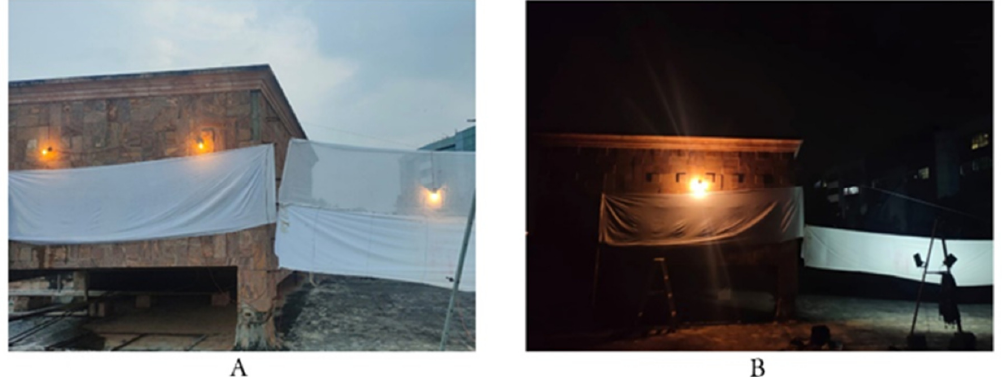
Figure 3. Moth light trap: A. During evening; B. During